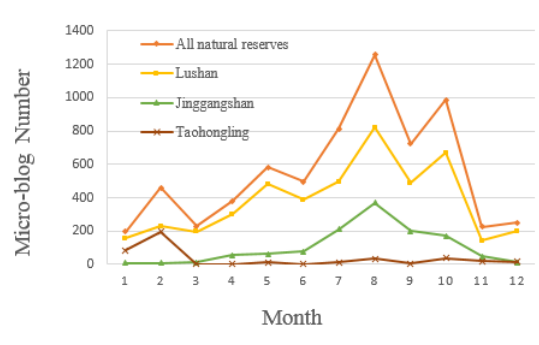
Figure 5 Microblogging number varied with time